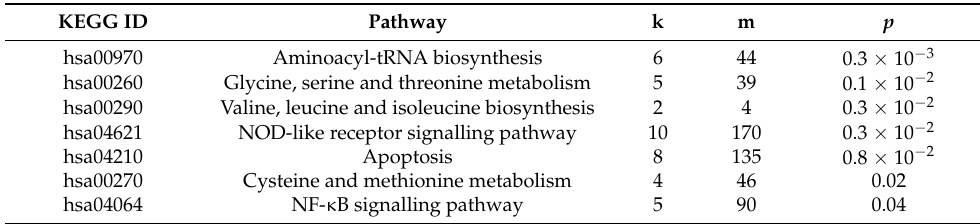
Table 2. Polymyxin B down-regulated the expression of 385 genes in A549 cells enriched by KEGG pathway analysis ( p < 0.05). k: number of DEGs in a pathway; m: number of background genes in a pathway; p : p value. KEGG ID Pathway k m p hsa00970 Aminoacyl-tRNA biosynthesis 6 44 hsa00260 Glycine, serine and threonine metabolism hsa00290 Valine, leucine and isoleucine biosynthesis hsa04621 NOD-like receptor signalling pathway